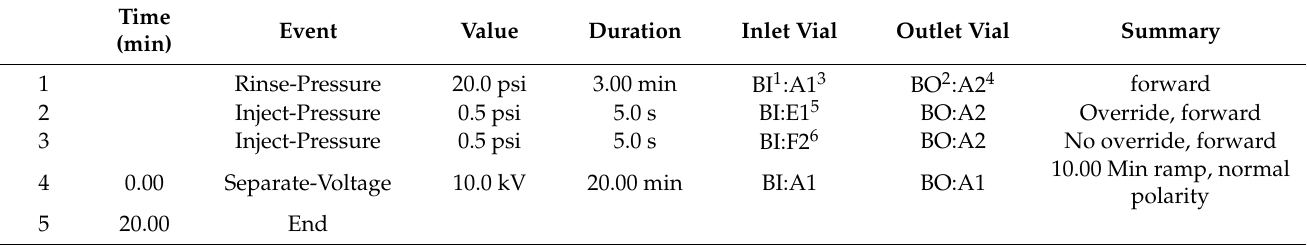
Table 3. Washing sequence and schedule of the capillary